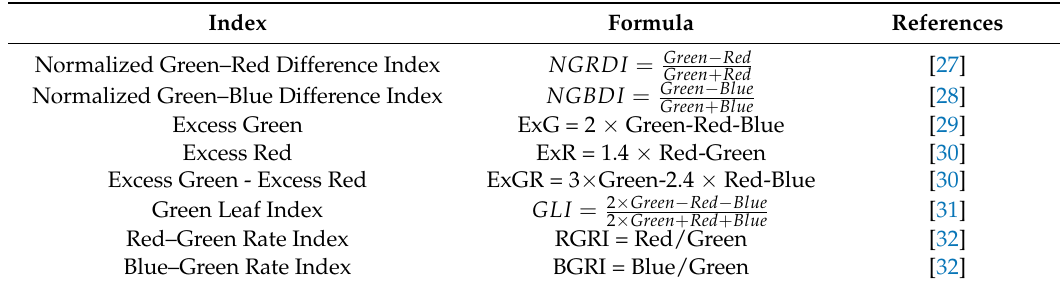
Table 2. Summary of selected vegetation